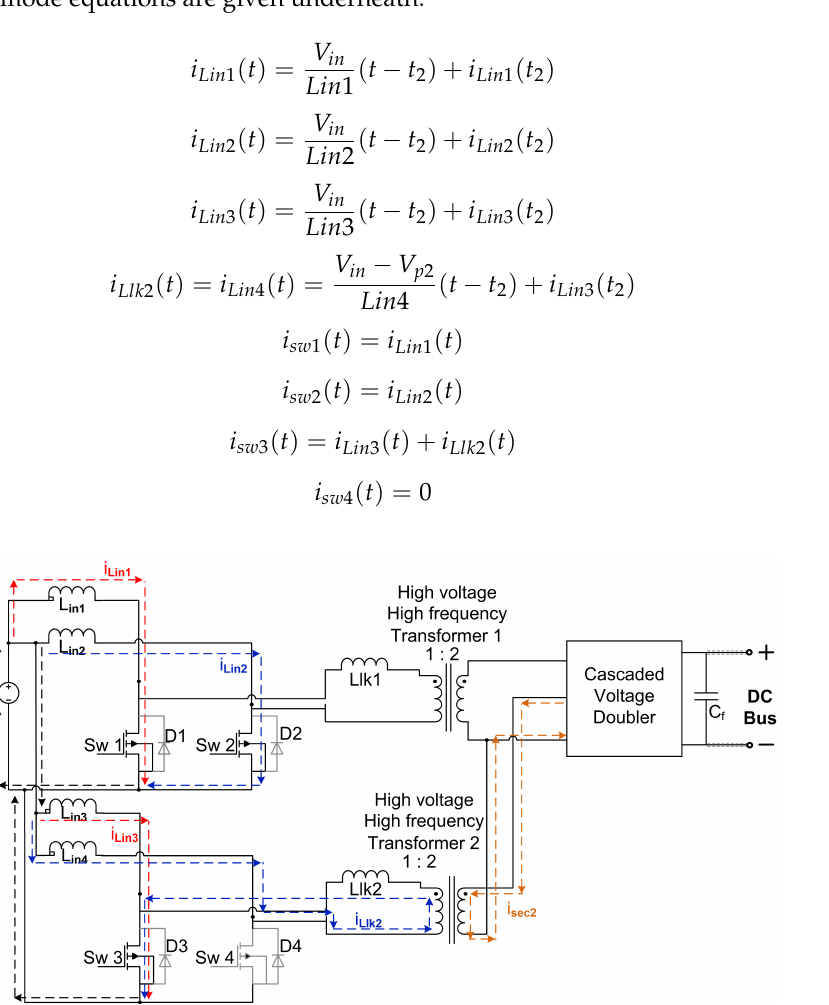
Figure 5. Mode 3